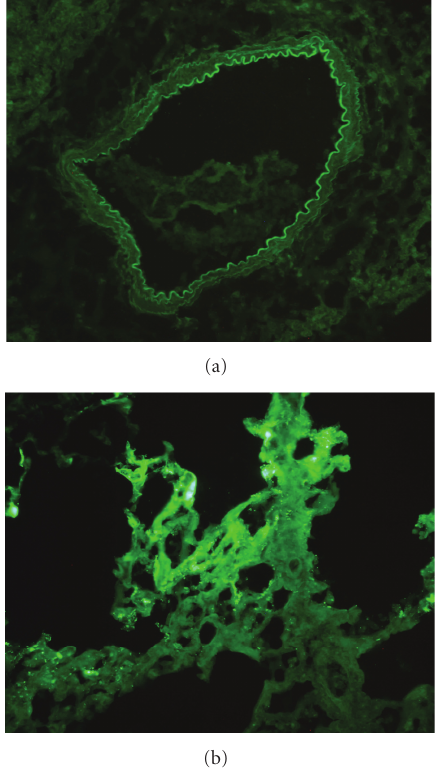
Figure 3: (a) and (b) represent adenovirus transfected into bron- chus epithelial cells (a) and alveolar epithelial cells (b), respectively. The green fluorescence represents the adenovirus.